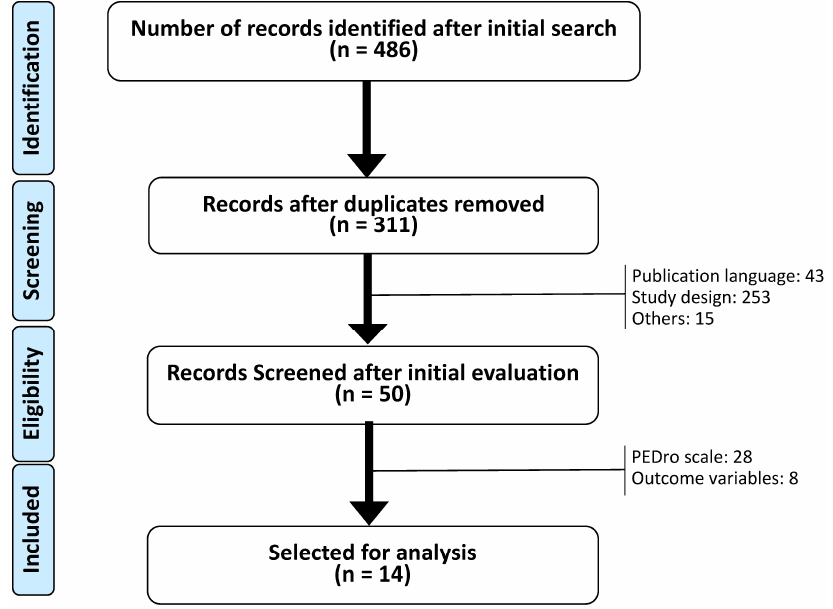
Figure 1. Flowchart CONSORT.